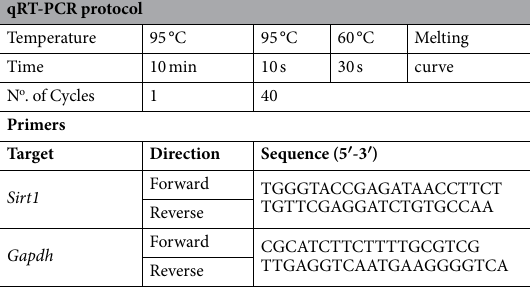
Table 2. Protocol details and primers